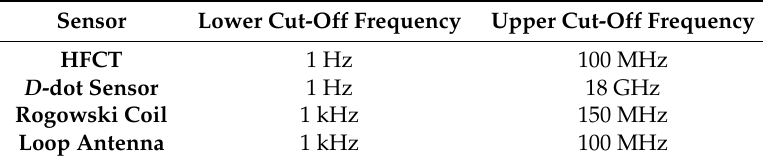
Table 1. Properties of PD